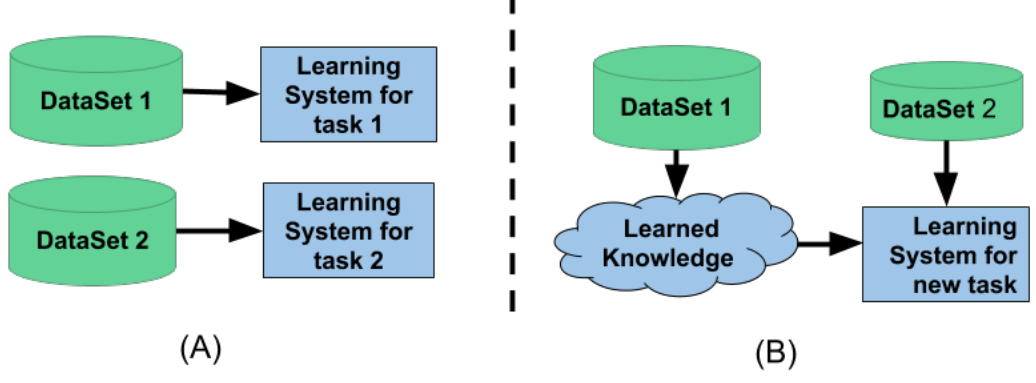
Figure 4. ( A ) Traditional machine learning system ( B ) Transfer Learning